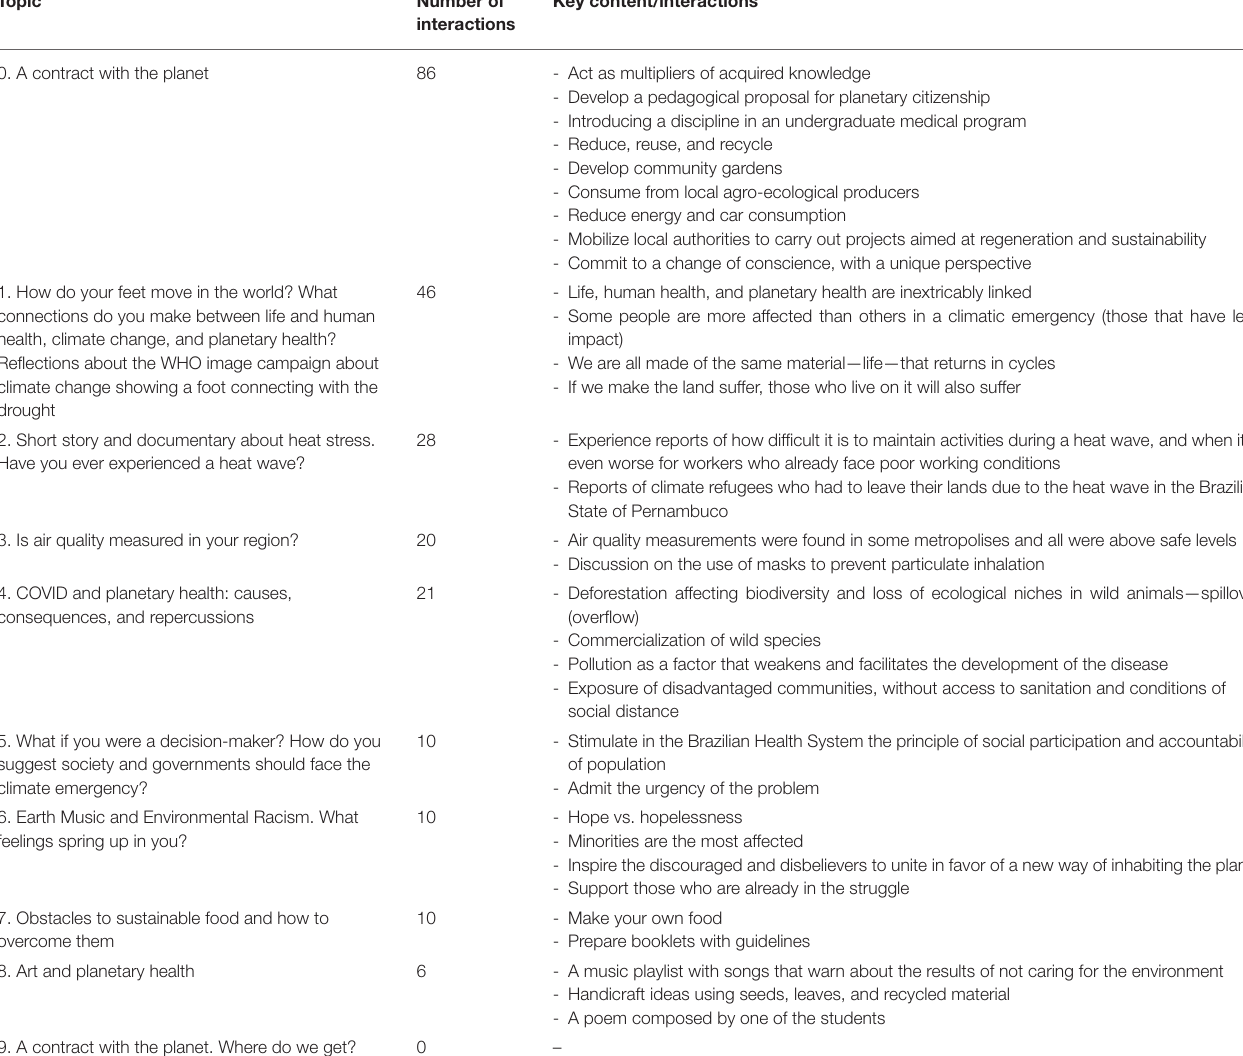
TABLE 4 | Forum topics to encourage discussion, number of interactions, and key content/interactions. Topic Number of